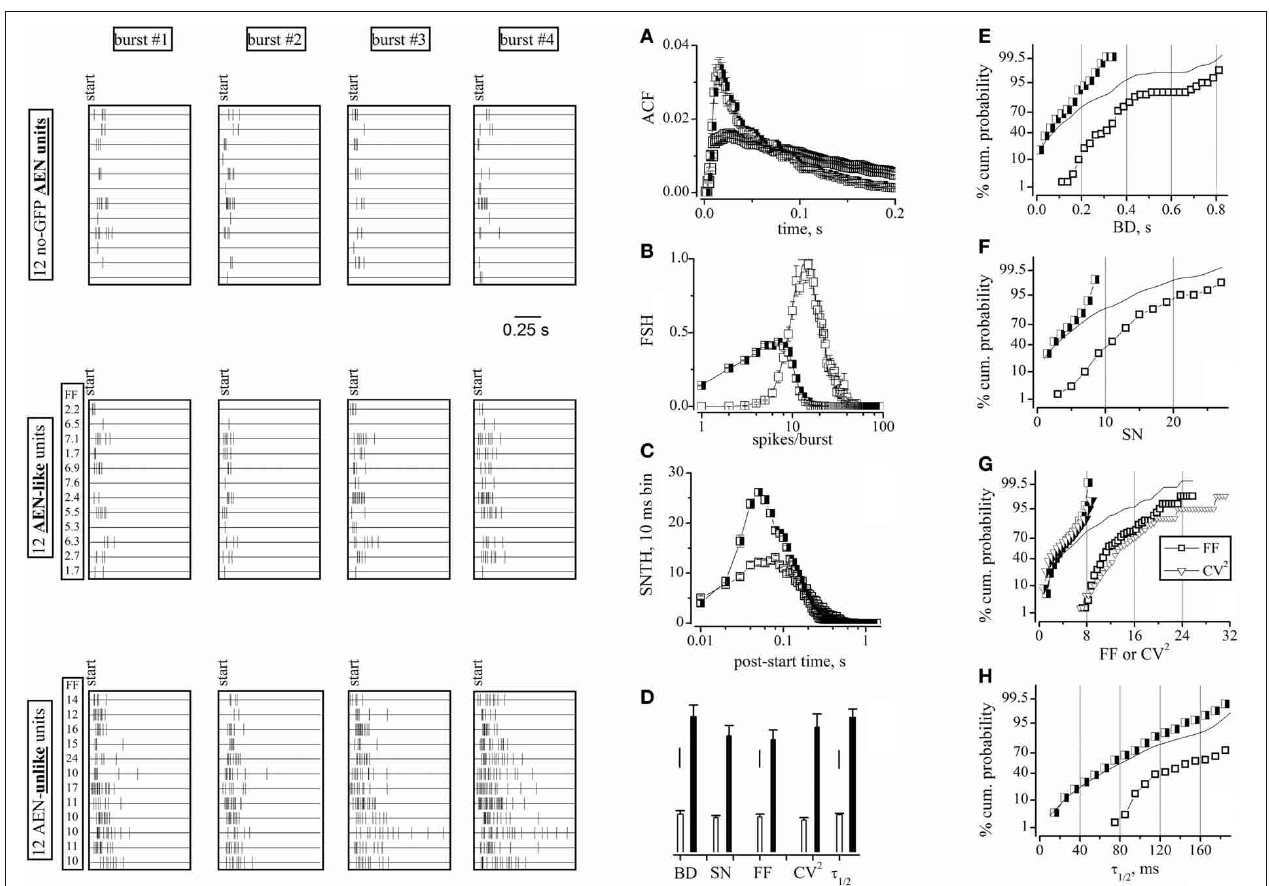
FIGURE 4 | Rasterplotsof cellactivity andstatistical properties of neuron clusters. Data were obtained from the same experimentsand time segments as shown in Figure 3 , but using all 98 units. Left panels: four-bursts raster plots for 12 neurons (duration, 1s). Upper left: spike bursts recorded from electrodes devoid of GFP + cells (the 2nd and 3rd row from top correspond to units62band 62a,whose waveformsare shownin Figure 3 . Middle-left:spike bursts of the AEN-like type (see the main text). Lower-left: spike bursts of the AEN-unlike type. The left columns labeled FF in the middle and lower panels give the average FF values of each units. (A–C) ACF, FSH, and SNTH plots, respectively, obtained by using the software clusterization of the 78 and 20